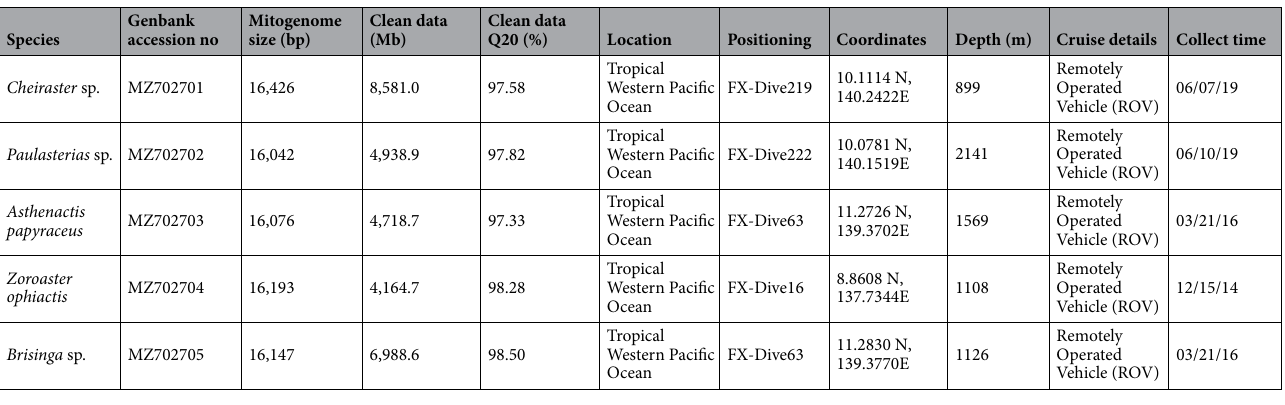
Table 1. New mitochondrial genomes analyzed in present